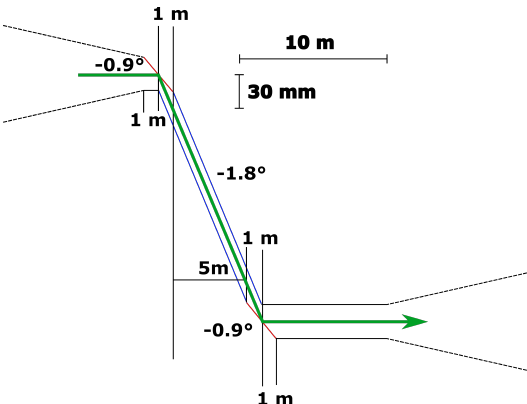
Figure 4. Sketch drawing of the deflector setup. This shows a vertical section through the deflector. Red lines designate m = 4 supermirrors, inclined by 0.9°, blue lines indicate m = 4 supermirrors inclined by 1.8°. The sides are coated with m = 1 supermirrors, since no vertical displacement of the beam center in necessary. The dashed lines at the beginning and end outline the transported divergence for the shortest collimation with the widest opening (3 cm beam cross section over 4 m collimation length). The central neutron beam is indicated in